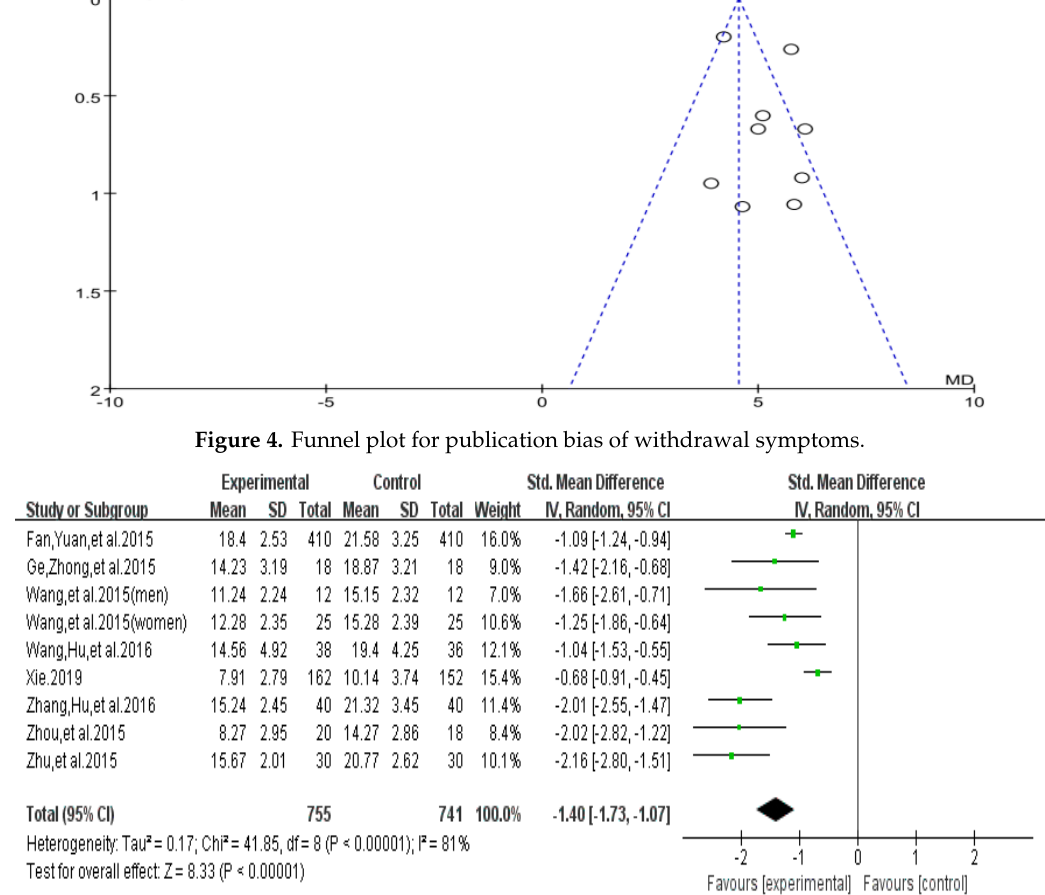
Figure 5. E ff ect of exercises on withdrawal